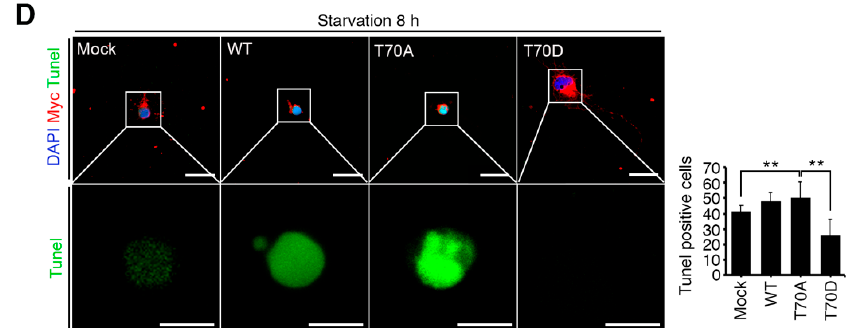
Figure 2. Starvation induced neuronal death by upregulating RPS3 and decreasing phosphorylation of RPS3-T70. ( A ) Brains of starved mice were isolated and subjected to immunohistochemical analysis. The hippocampus was stained for RPS3 (red, left) or p-RPS3 (red, right) and MAP2 (green). The right-hand panel shows higher magnification of the CA1 region of the hippocampus, indicated by a white box. Scale bar, 1 mm (left), 100 μ m (right). Fluorescence intensities were measured by ZEN (ZEISS) and their values were normalized with normal mouse brain. ( B ) Neuronal cells in CA1 were stained with DAPI (blue) and an anti-NeuN antibody (green), and apoptotic cells with condensed-chromatin signs were counted. Arrows indicate death of cells. Scale bar, 1 mm (upper), 100 μ m (bottom). ( C ) A representative merged image of protein expression levels of endogenous RPS3 or p-RPS3 (red) and p-AKT (green) with or without B27 serum starvation condition (short-term starvation, STS, or prolonged starvation, PS) in the hippocampal neurons (upper). Apoptotic cells quantified with the TUNEL assay (green) and an anti-RPS3 antibody (red, left), and TUNEL-positive cell numbers are presented in the bar graph (right). Scale bar, 20 μ m. ( D ) Cultured neurons were transfected with Myc-RPS3 WT, T70A, T70D, or Myc control vector on day 1 after plating (DIV 1) and incubated with or without B27 at DIV 3. The cells were fixed and co-stained with an anti-Myc antibody (red) and subjected to a TUNEL assay (green). The mice ( n = 20) were subdivided into four groups: Normal and Starvation for 24, 72, and 120 h. Quantification of neuronal cell survival rates from three independent experiments is shown (right). Scale bar, 20 μ m; Statistical significance was calculated using a one-way ANOVA test followed by Turkey’s post-test (* p < 0.01; ** p < 0.001).